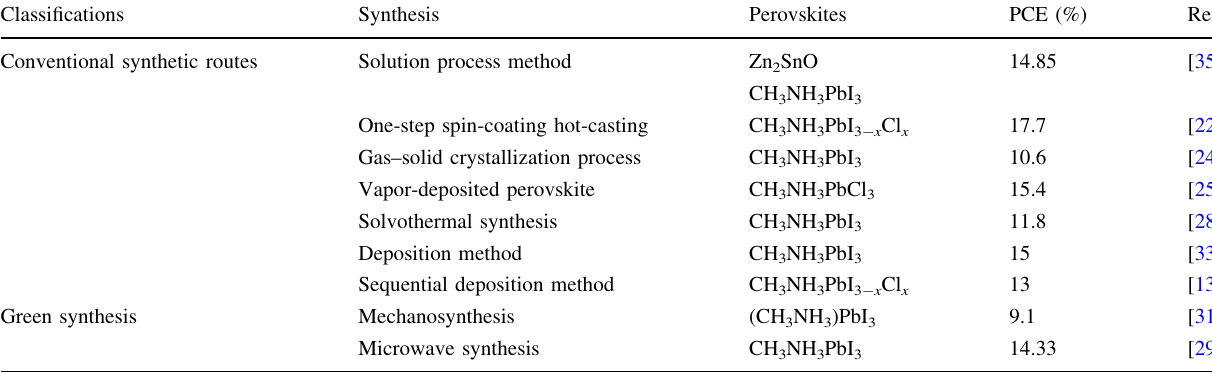
Table 4 Compiled data of the highest efficiency reported for the perovskite solar cells by conventional and green methods Classifications Conventional synthetic routes